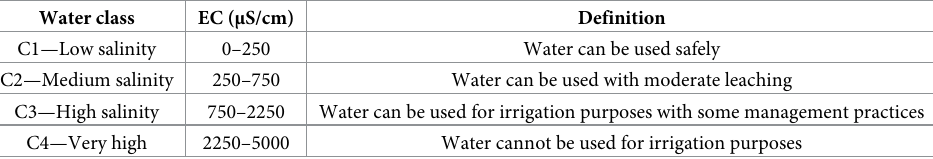
Table 4. Salinity hazard zones: Based on electrical conductivity.